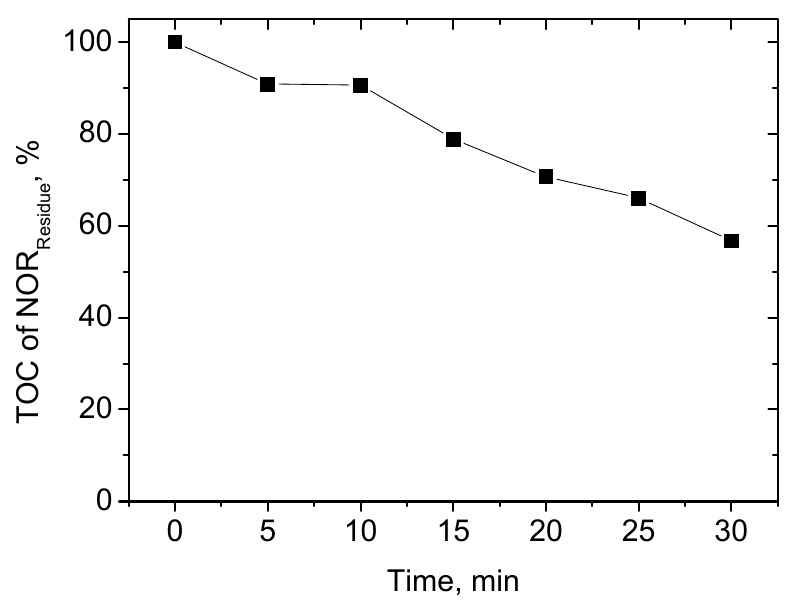
Figure 10. Removal of TOC during the degradation of NOR by the MW/UV process (experimental conditions: microwave power = 500 W, UV light intensity = 31.8 mW/cm 2 , [NOR] = 5 mg/L, and pH = 6.72).